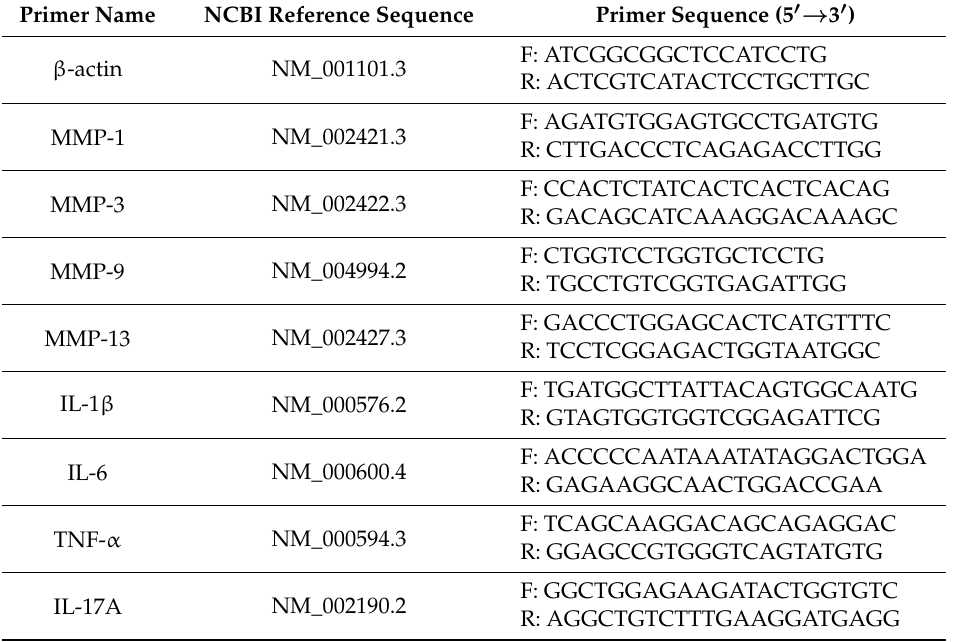
Table 1. Primer sets for qPCR